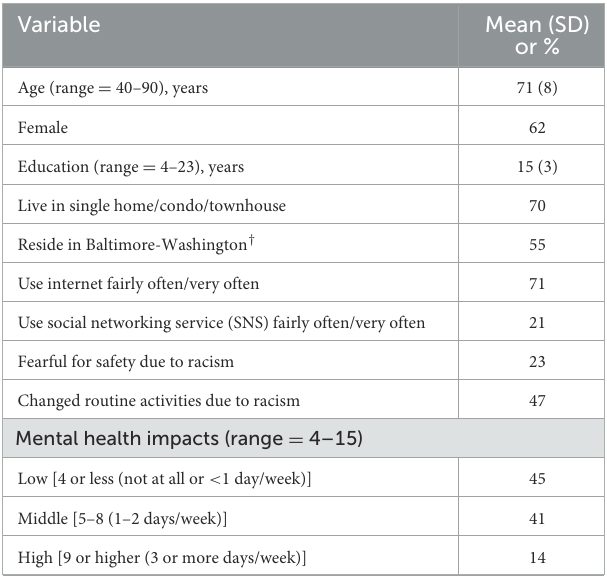
TABLE 1 Survey sample characteristics ( N =